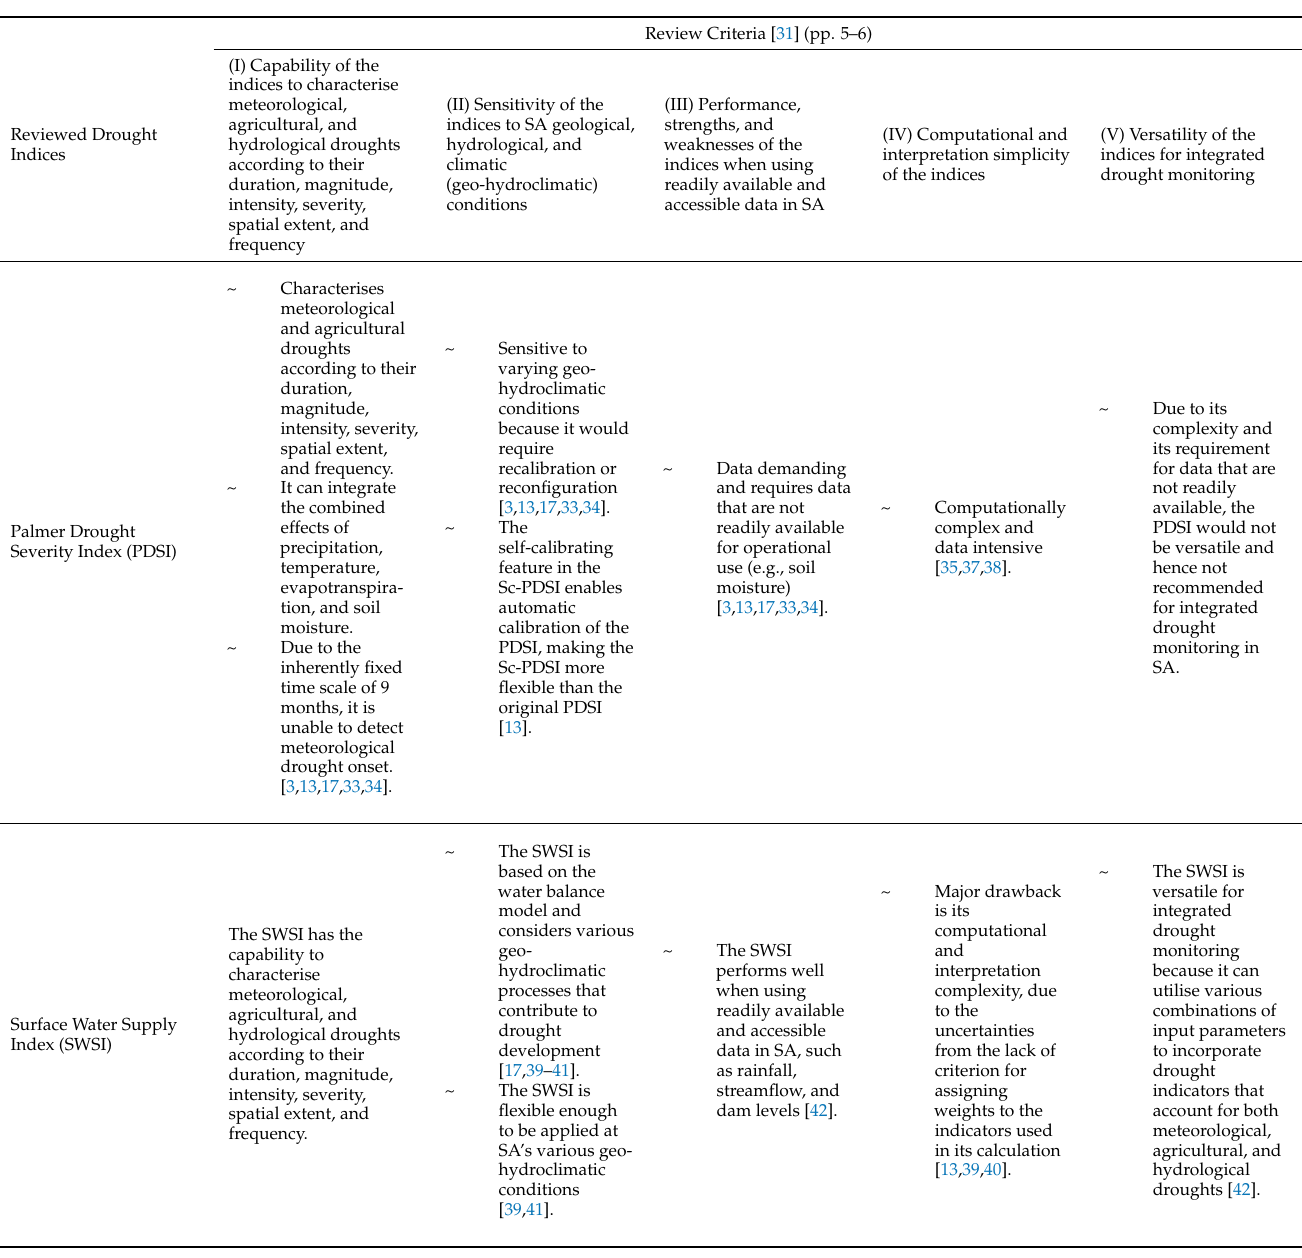
Table 1. Review of the PDSI and the SWSI; based on the 2016 WMO Handbook of Drought Indicators and Indices [31] (pp.